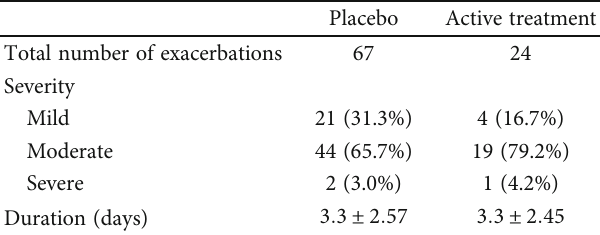
Table 3: Severity and duration of exacerbations during the